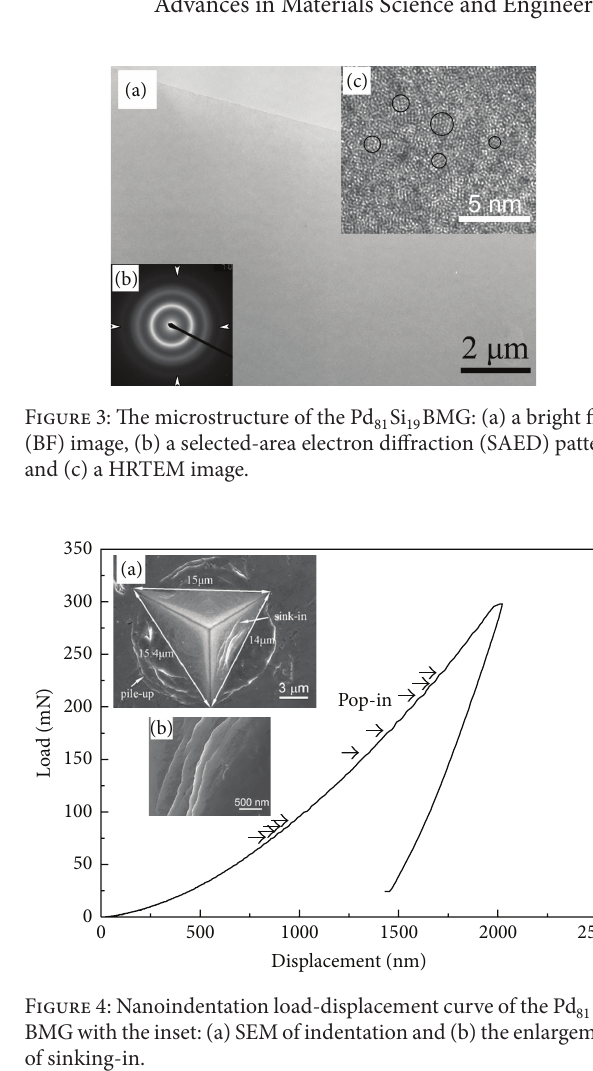
Figure 2: DSC curve of the Pd 81 Si 19 BMG with a diameter of 10 mm.